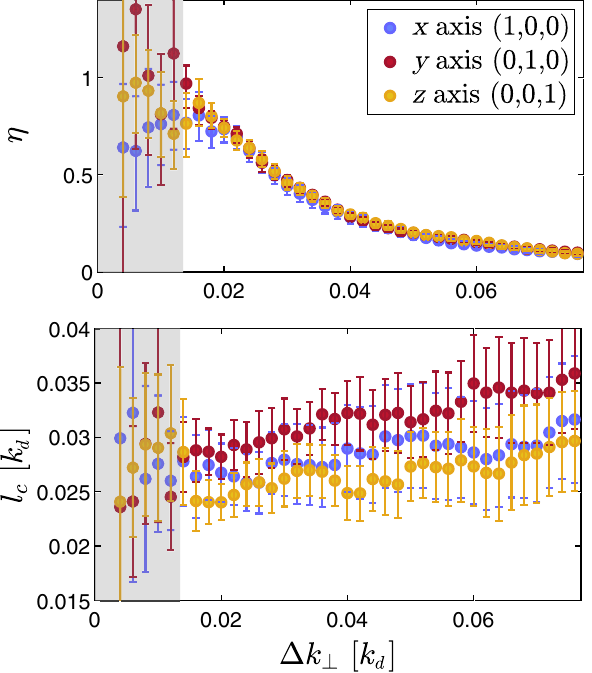
FIG. 8. Effect of the transverse integration on g ð 2 Þ ð δ k Þ . (a) Am- plitude of the bunching η as a function of Δ k ⊥ for the data used in Fig. 2. (b) Correlation length l as a function of Δ k ⊥ . Gray areas c on both graphs correspond to the region where the signal is too noisy to provide quantitative information.